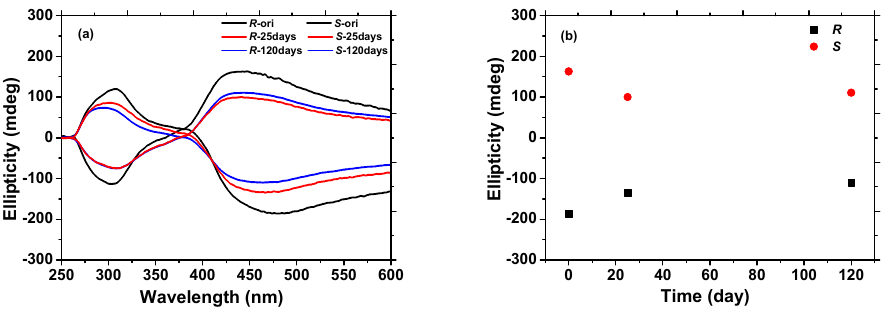
Figure 4. Changes in the CD spectra ( a ) and the maximum CD ( b ) of the PAzoMA 1 aggregates in the films without the existence of limonene.